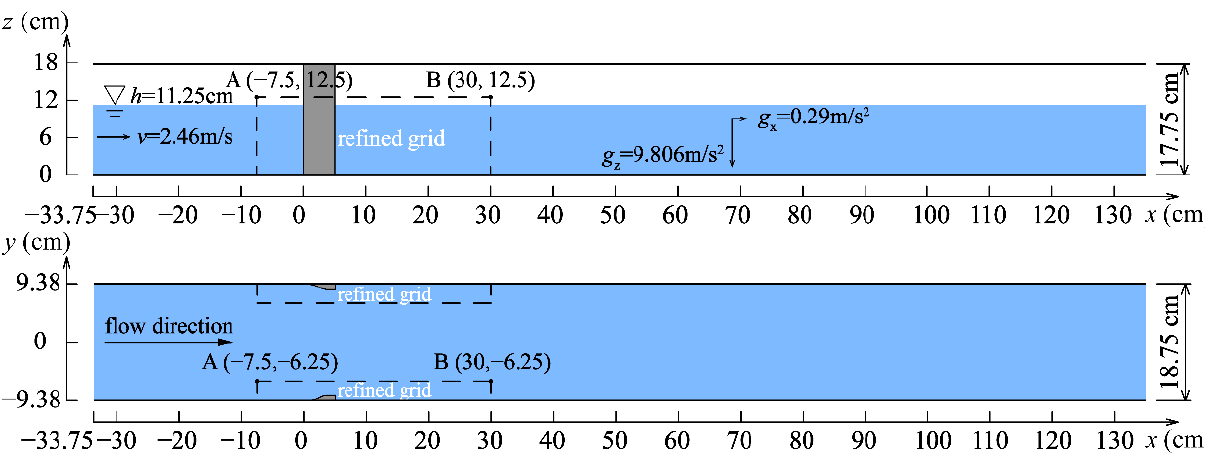
Figure 2. Schematic diagram of the simulation setup.